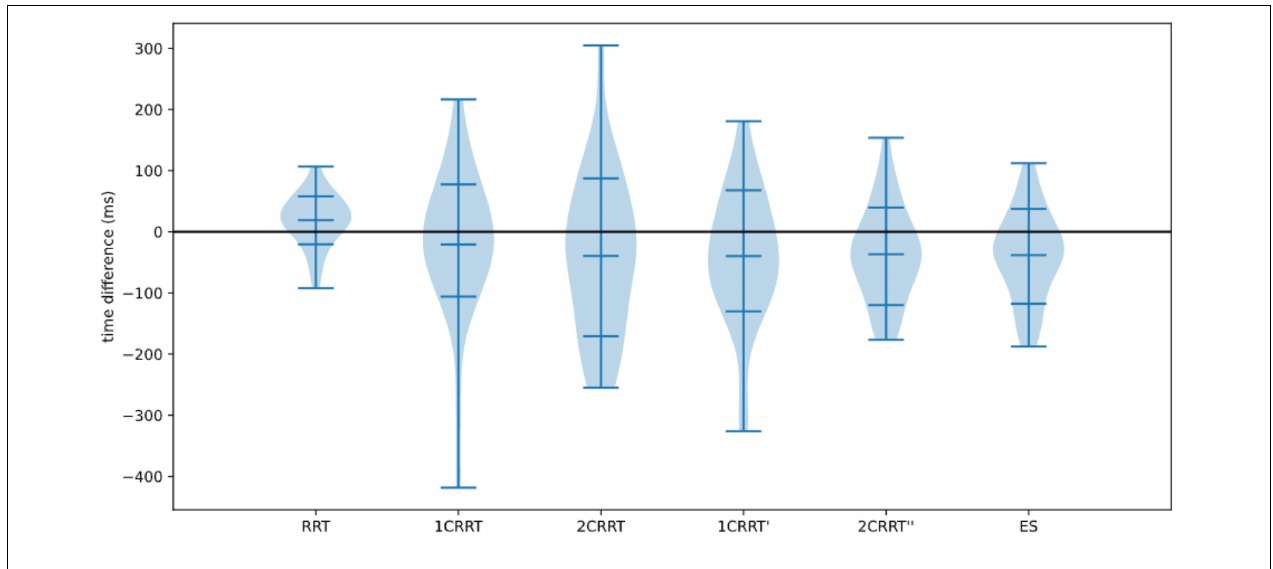
FIGURE 12 | Distributions of differences